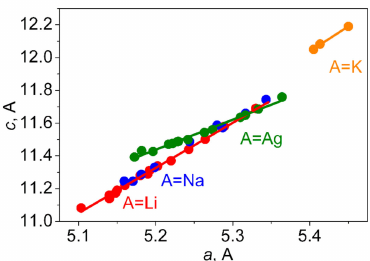
Figure 3. Cell parameter field c–a of AB(MoO 4 ) 2 (A = Li, Na, Ag, K; B = RE) crystallized in space group I 4 1 / a